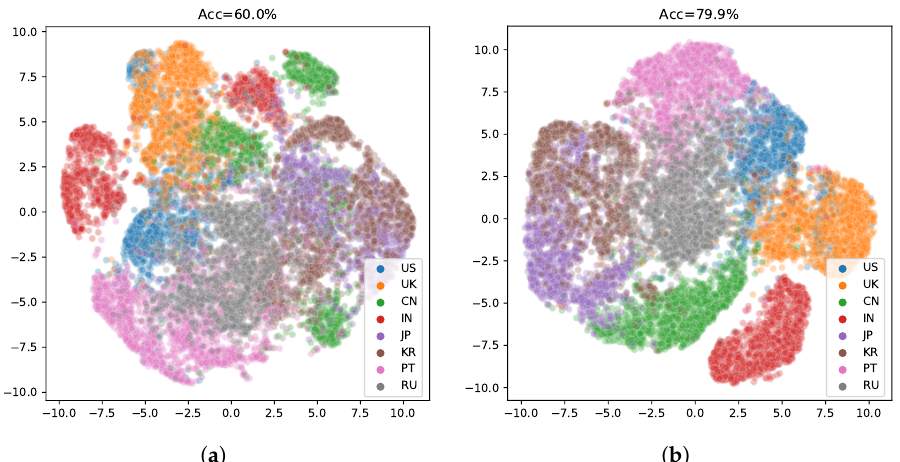
Figure 6. 2D embeddings of the accent features. ( a ) The baseline version without the auxiliary ASR task. ( b ) The proposed MTL version.